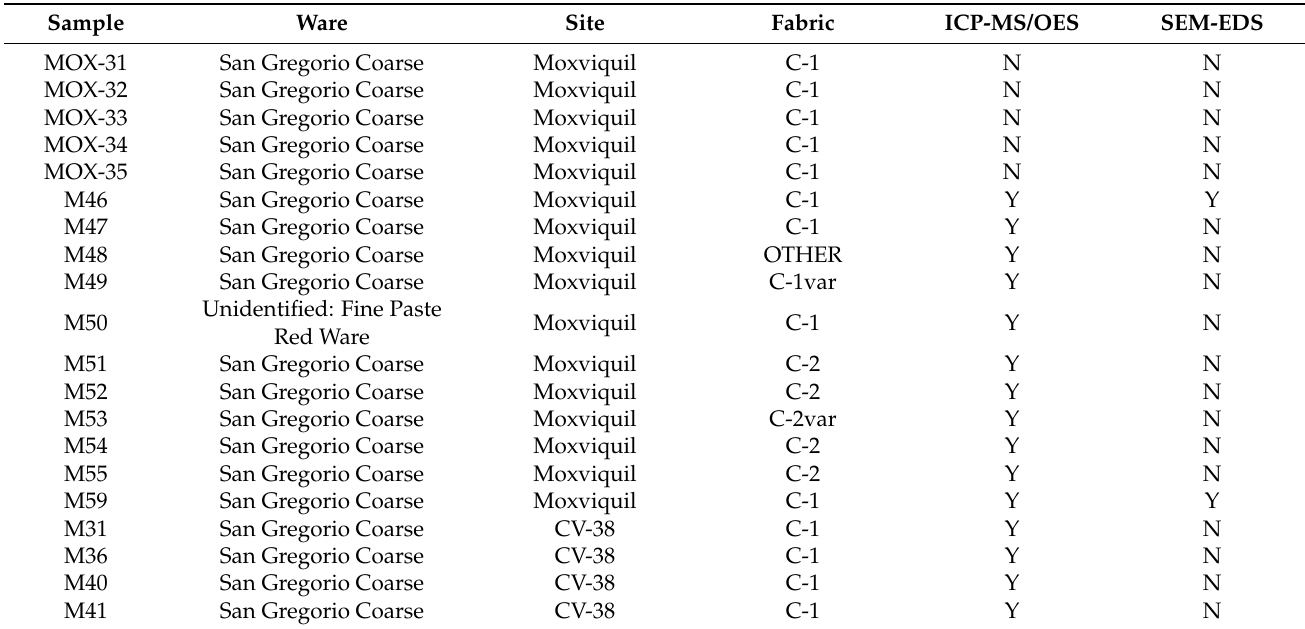
Table 1. List of the sherds presented in the paper with notes on whether they were sampled for chemical analysis. N—“No, analysis not carried out”; Y—“Yes, analysis